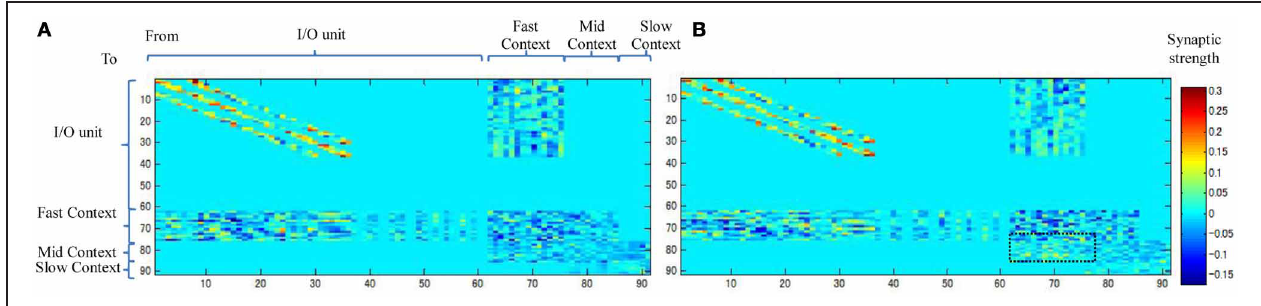
FIGURE 10 | Synaptic weight matrices for (A) Static memory and (B) Dynamic memory (the plots are the average of three static and dynamic memories). Synaptic connections between units are shown in Figure 6 .